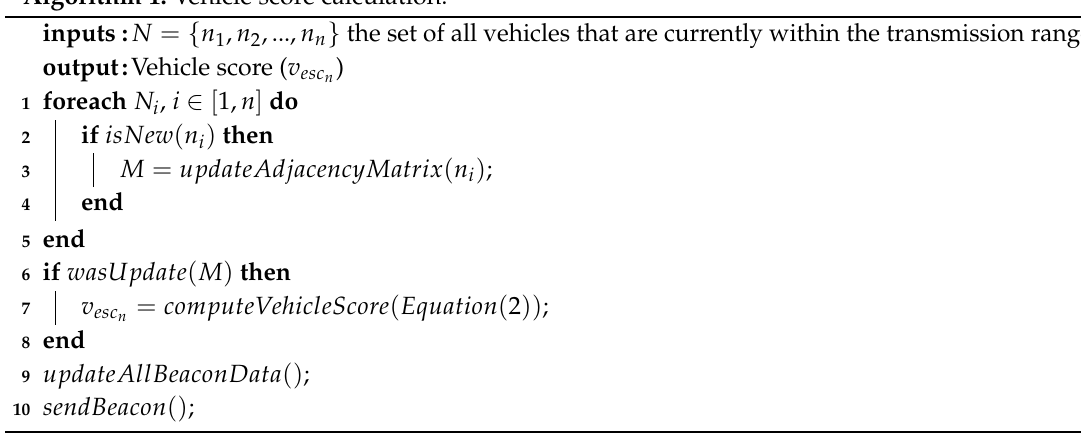
Algorithm 1: Vehicle score